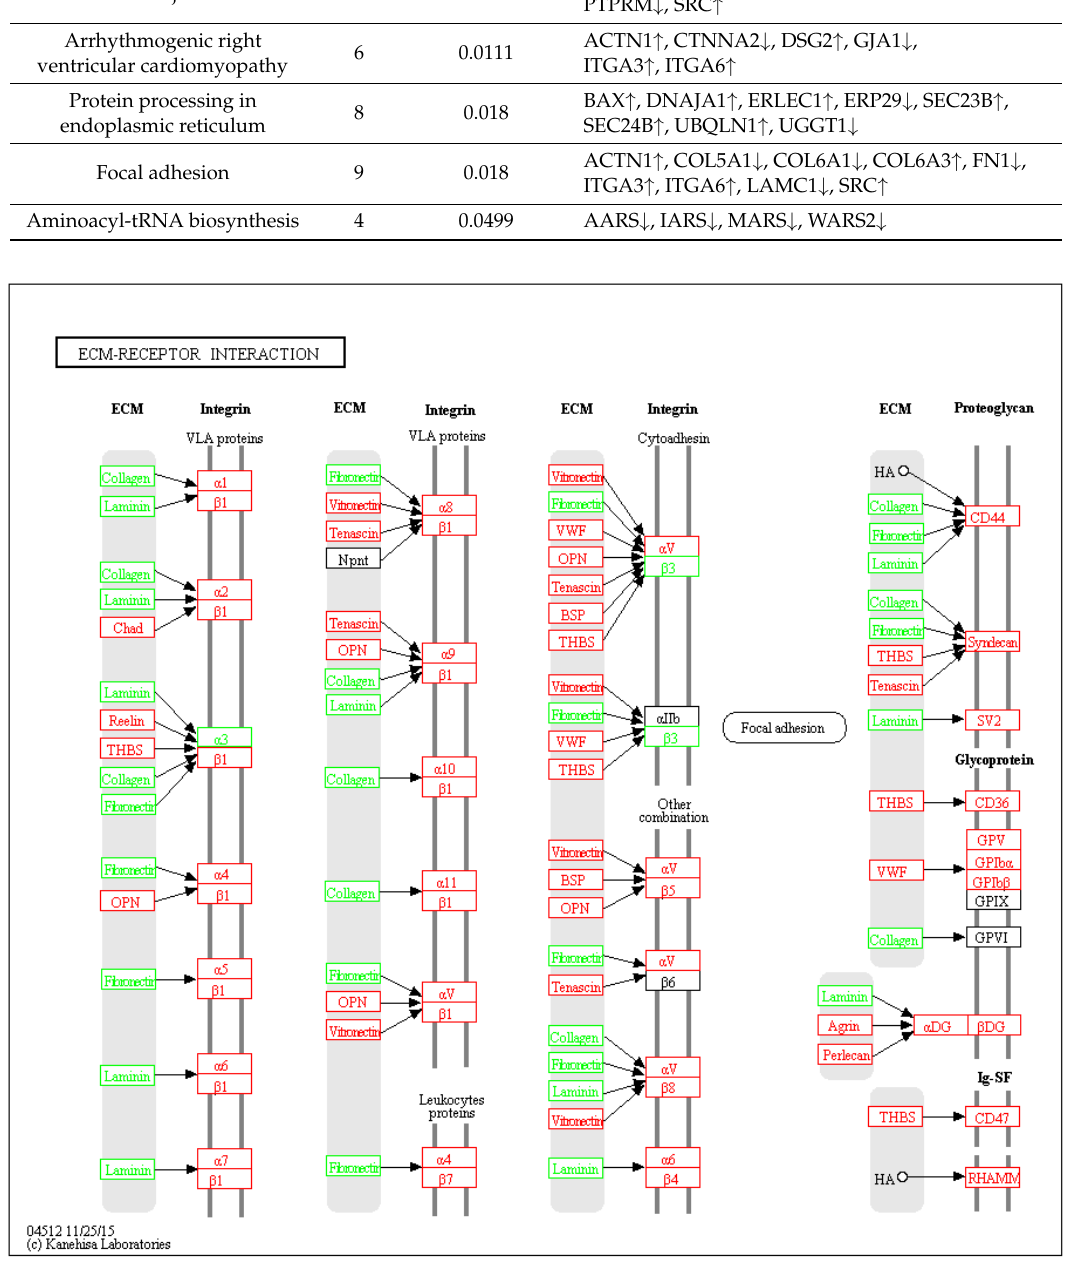
Figure 5. DEPs in the ECM-receptor interaction pathway. Green block: DEPs; red block: genes in transcriptome of the PPCs.